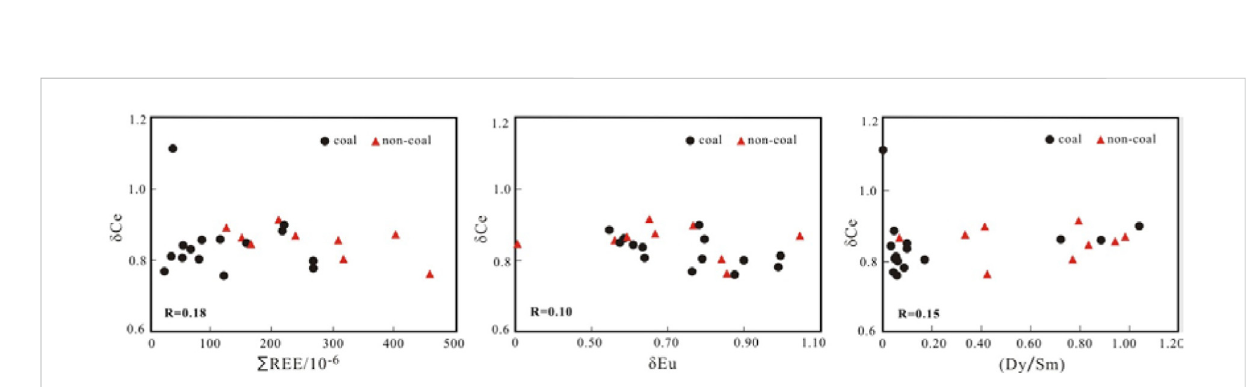
FIGURE 4 δ Ce correlate with δ Eu, (Dy/Sm)